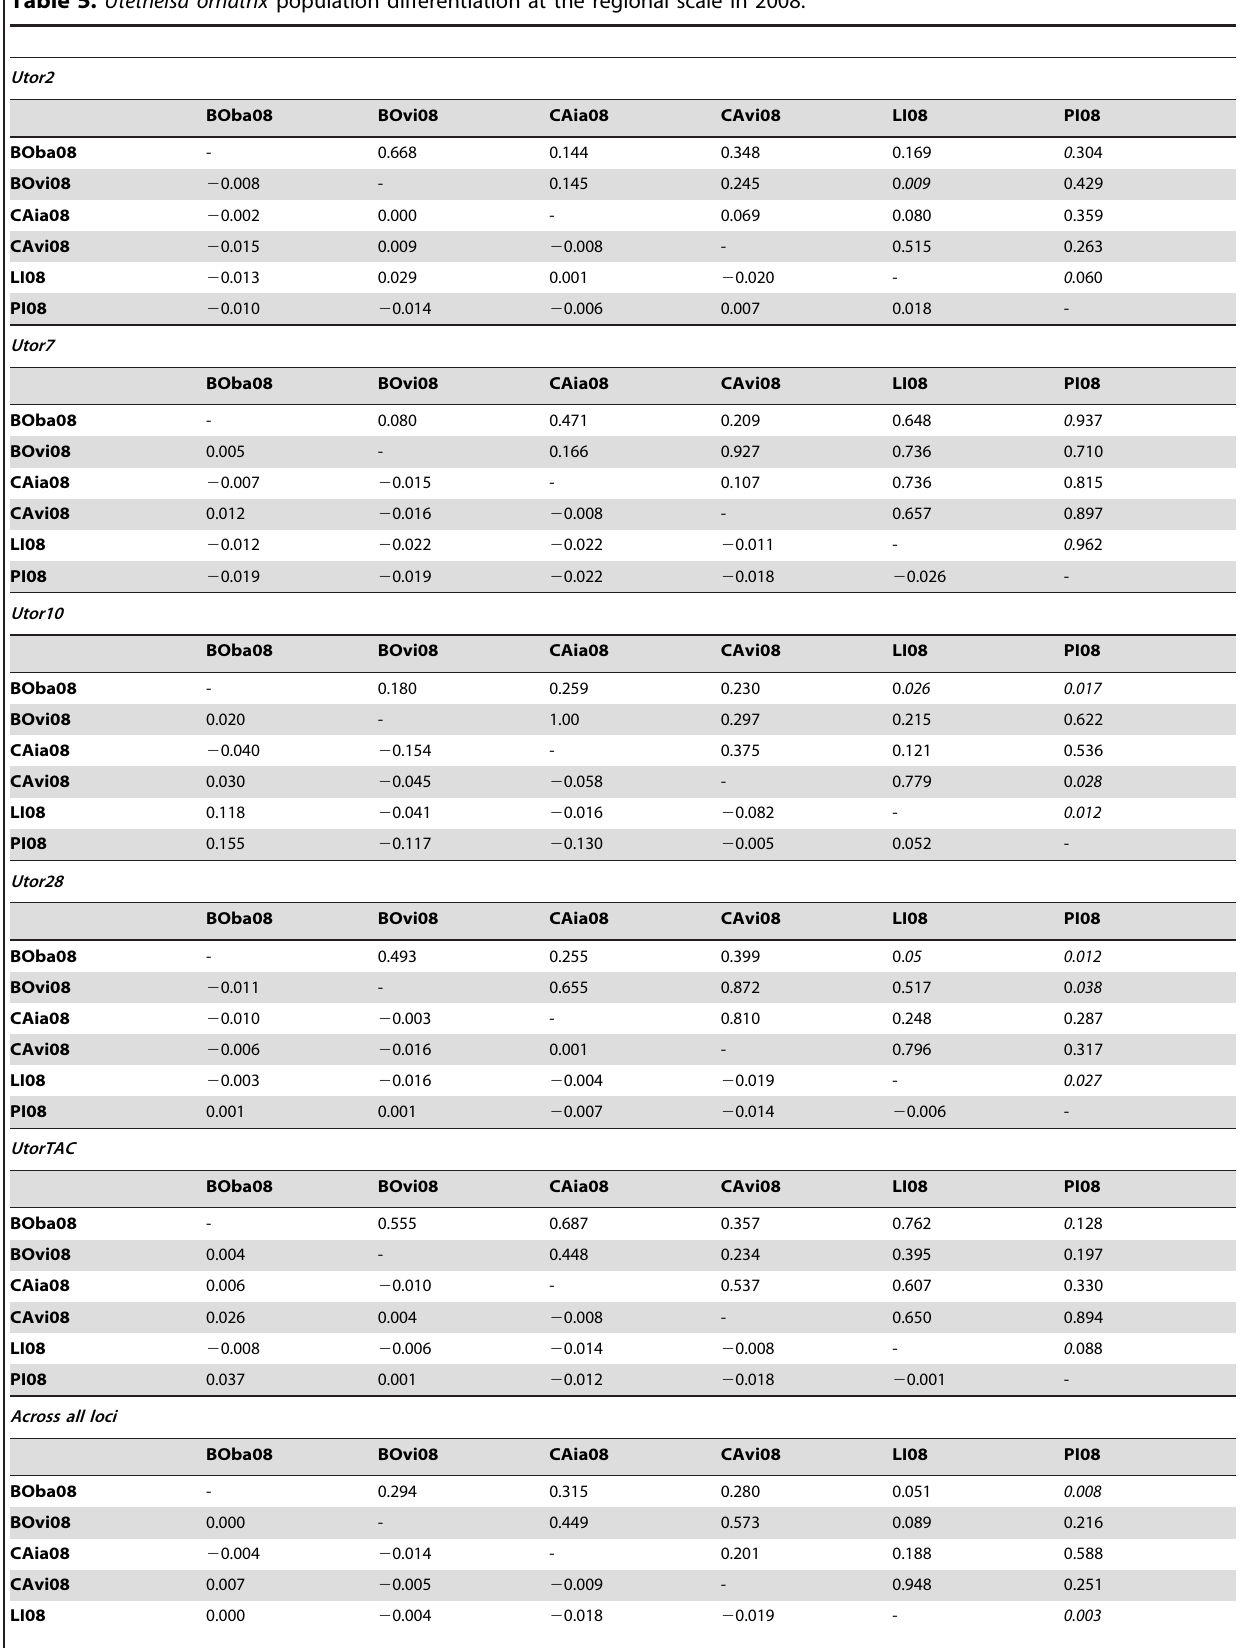
Table 5. Utetheisa ornatrix population differentiation at the regional scale in